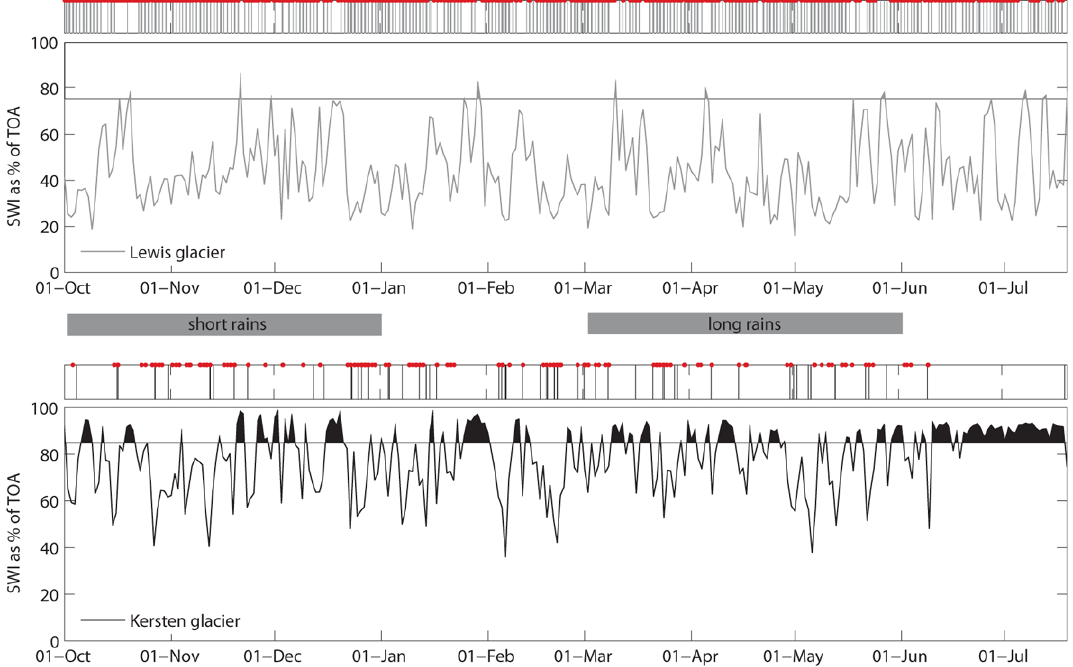
Fig. 8. Time series of daily incoming shortwave (SWI) as a percentage of extraterrestrial radiation (TOA) indicates clear-sky periods (above the horizontal line) when the ratio exceeds the respective limit for Lewis (75%) and Kersten (85%) glaciers. Panels above show a concurrent hourly time series of overcast sky conditions (vertical bars) and hours when atmospheric humidity reaches condensation conditions (red dots) at the AWS site. The gray bars in the center highlight the OND and MAM regional rainy